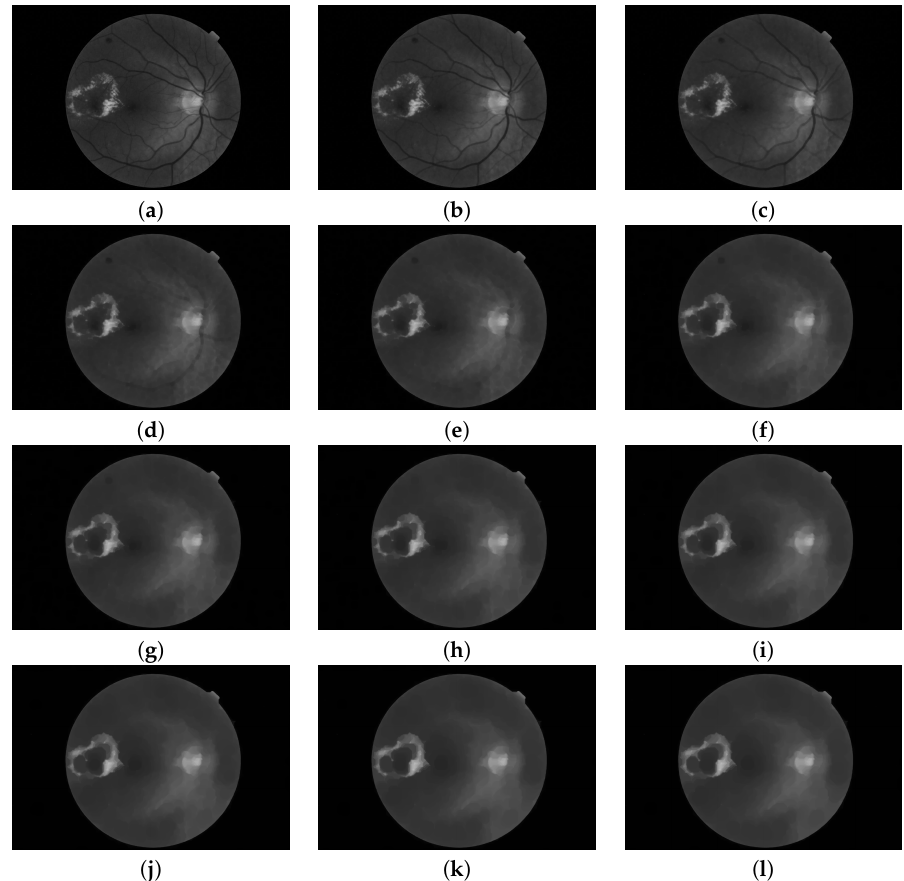
Figure 6. Pyramid of closings computed from a fundus image using an isotropic structuring element. It is composed by 12 images ( n = 0,2,4, . . . ,22). ( a ) Original image; i.e., ϕ 0 is the identity mapping; ( b–k ) are the results of applying the closing operator with increasing size (according to s = 2) and ( l ) is the last image of the pyramid corresponding to the operation ϕ nmax